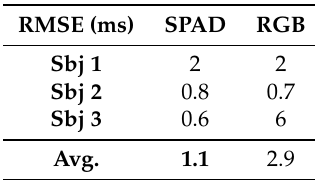
RMSE (ms) SPAD RGB Sbj 1 2 2 Sbj 2 0.8 0.7 Sbj 3 0.6 6 Avg. 1.1 2.9